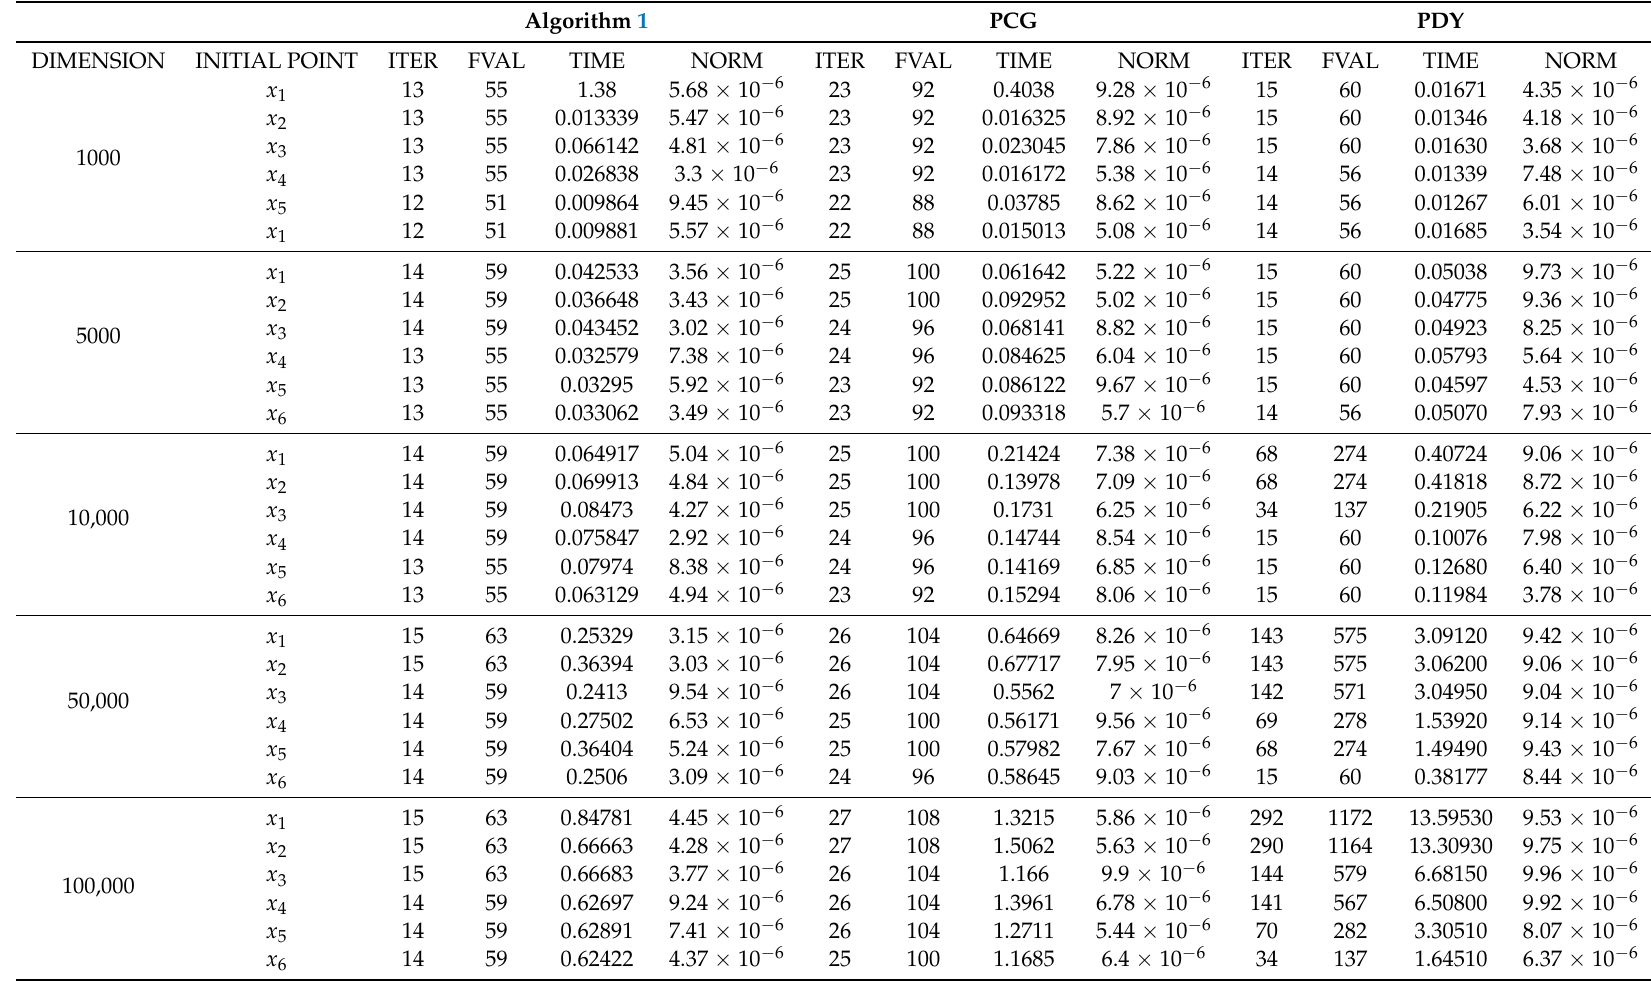
Table 6. Numerical Results for Algorithm 1 (DCG) , PCG and PDY for Problem 6 with given initial points and